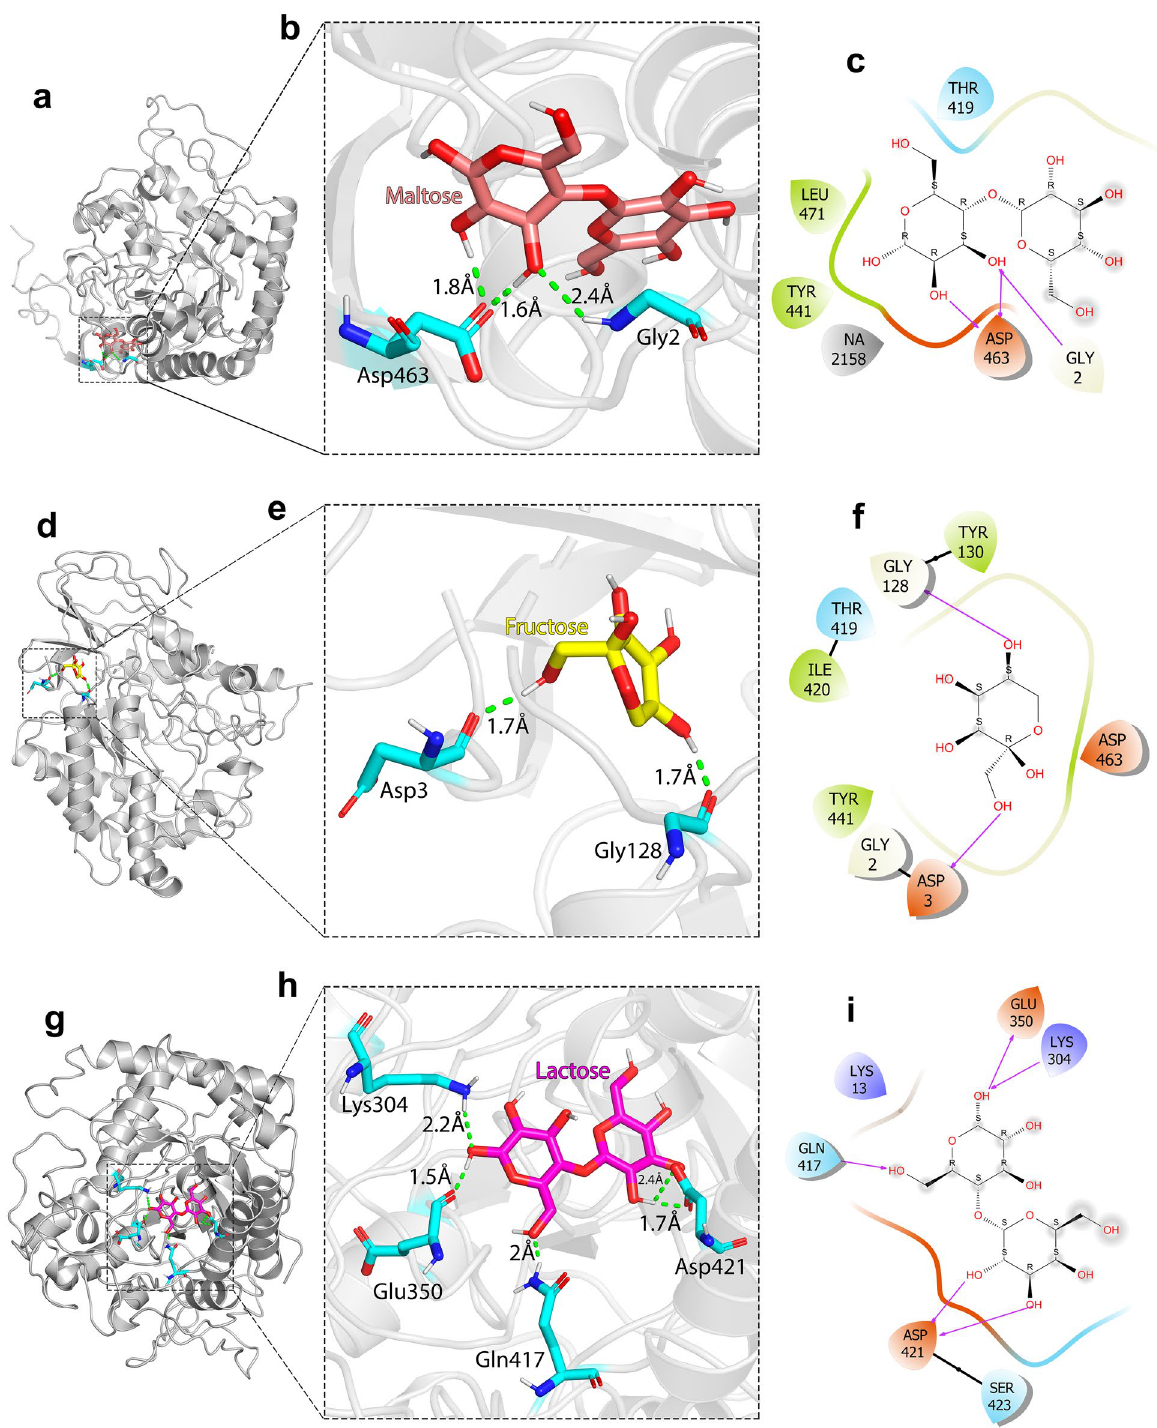
Figure 4. Docking results for CelC307 in complex with the sugar ligands. The complexes were pictured using PyMOL V.2.3.4. ( a ), ( b ) and ( c ) Docked CelC307-maltose complex and 2-D display interactions. ( d ), ( e ) and ( f ) Docked CelC307-fructose complex and 2-D display interactions. ( g ), ( h ) and ( i ) Docked CelC307-lactose complex and 2-D display interactions, after MD